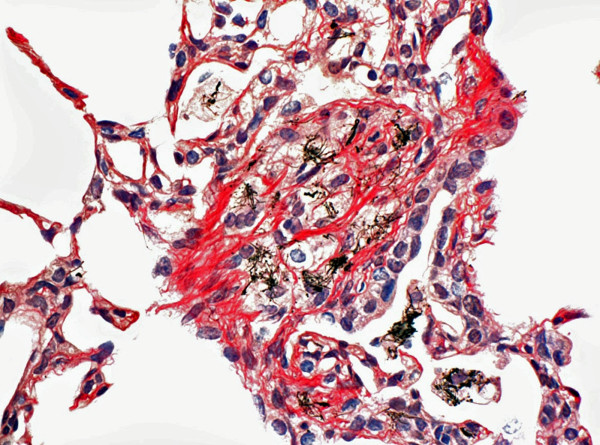
Light micrograph of fibrotic granulomas 56 days following MWCNT. Micrograph illustrates the extensive collagen network developed within granulomas that developed following a single 20 μg dose of MWCNT. Section stained with Sirius Red show collagen fibers in red.